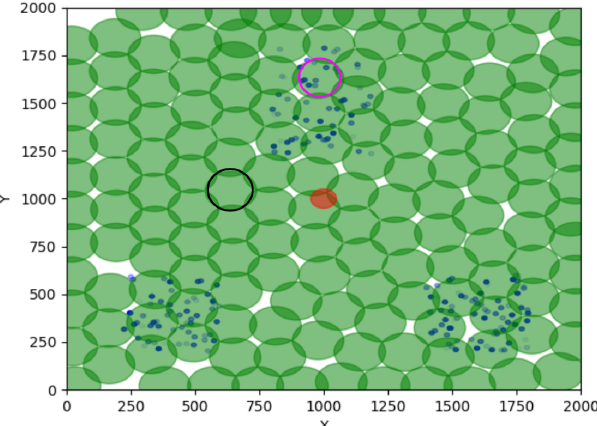
Figure 4. Deployment of UAVs at the end of the first phase on the third training scenario. Blue dots represent users, green circles represent UAVs’ coverage areas, and the red circle represents the location of the command center. A black circle shows an inactive UAV and the magenta circle shows an inactive